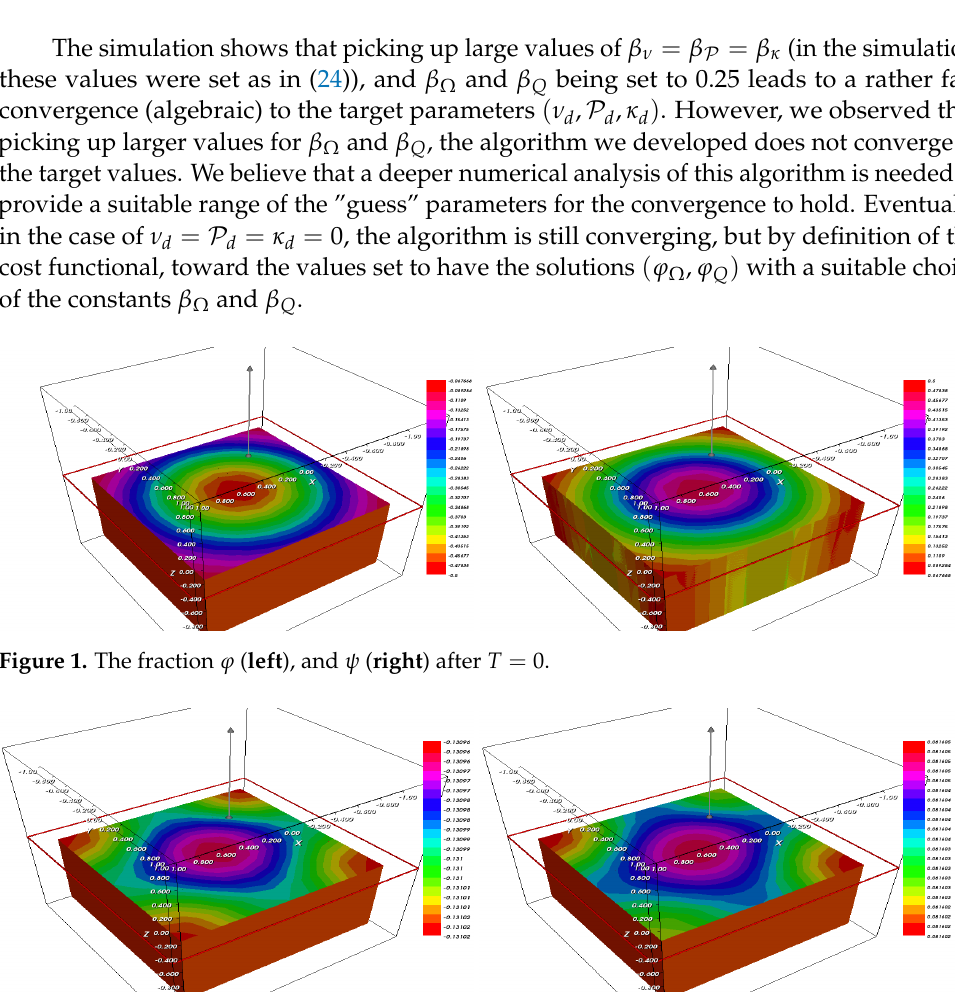
Figure 2. The fraction ϕ ( left ) and ψ ( right ) after T = 5.